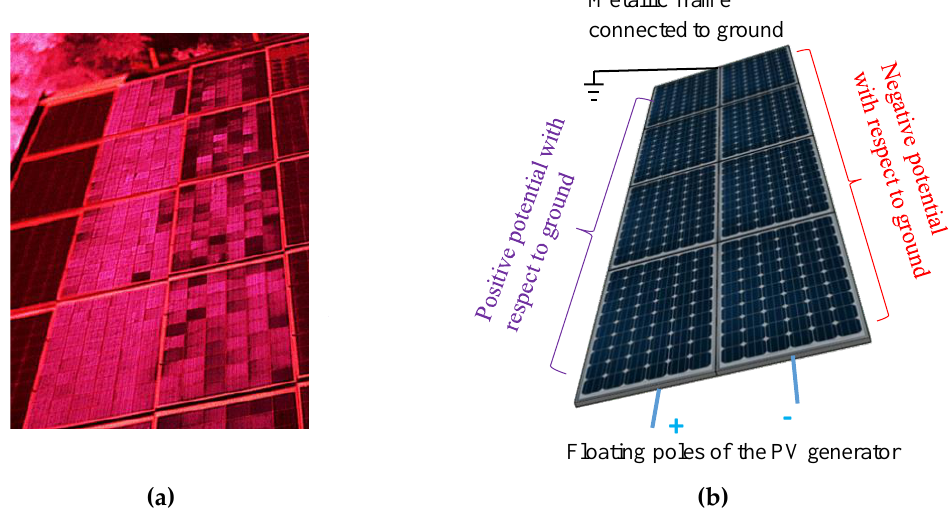
Figure 4. ( a ) EL image of a PV string of c-Si cells affected by PID; ( b ) identification of modules affected by a negative potential between the PV cells and the metallic frame connected to ground.